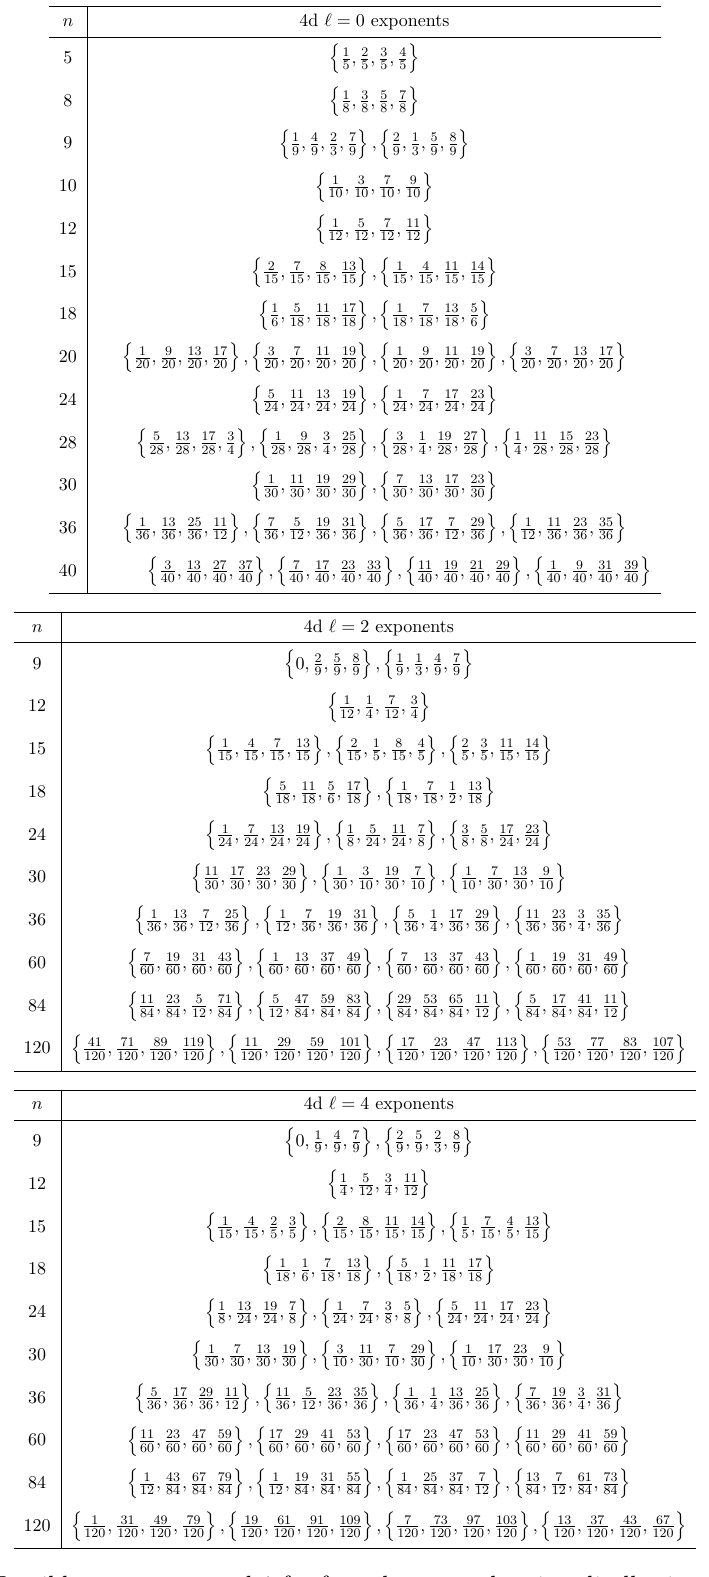
Table 13 . Possible exponents mod 1 for four-character theories, disallowing